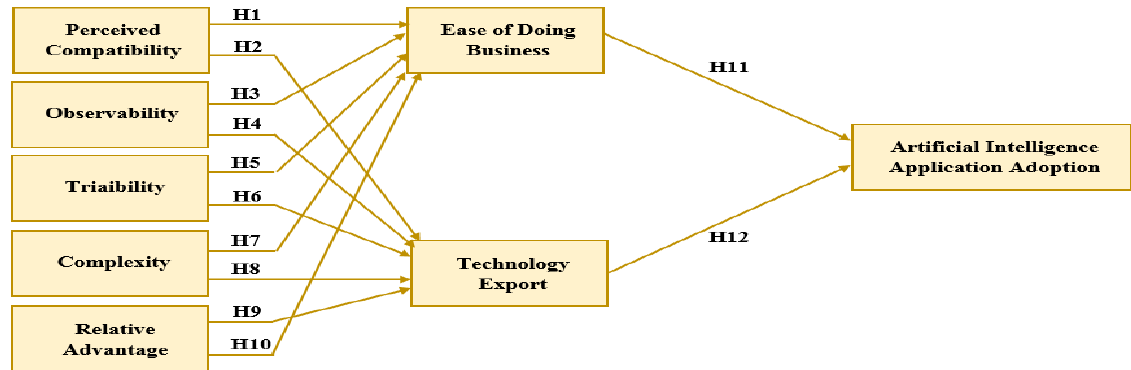
Figure 1. Research Model